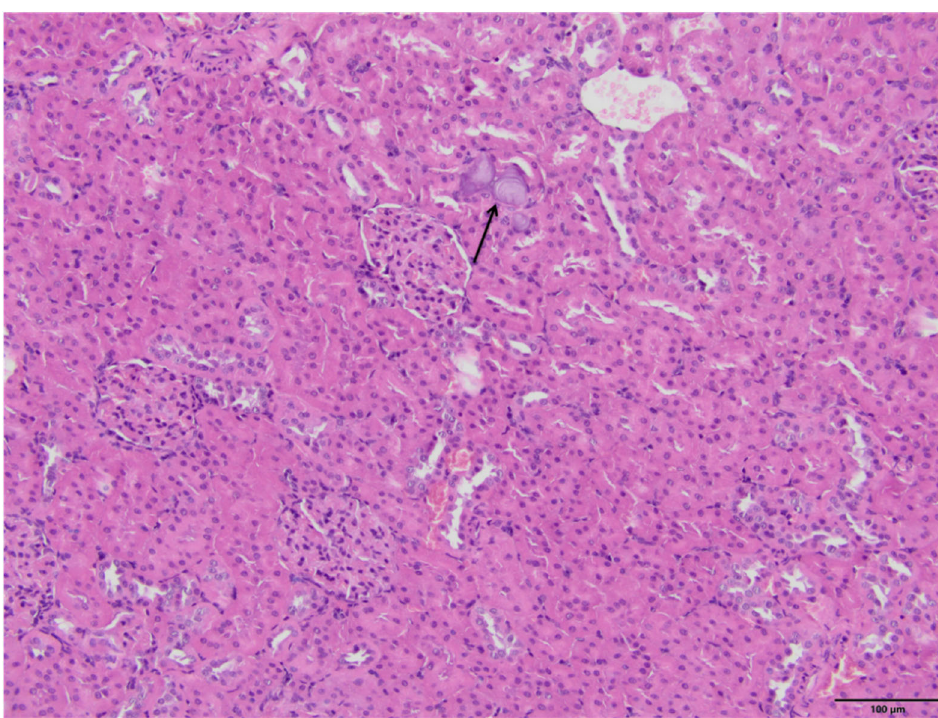
Figure 1. Pathological lesions in kidneys of rats on 10% fructose diet (F10). The purple concretions within the interstitium and tubules with ring ‐ like substructures (arrow). The deposits are non ‐ polarizable, displacing the proximal tubule epithelium and narrowing the lumen. (HE, magnification 20×).